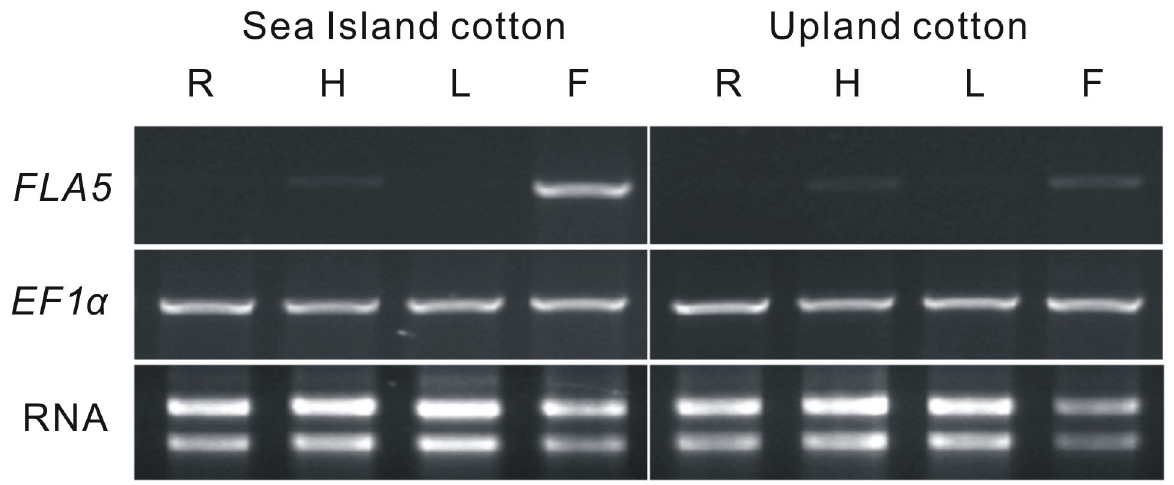
Figure 6. Expression analysis of FLA5 in various cotton tissues by semi-quantitative RT-PCR. EF1α was used as the internal control. Sea Island cotton ( G. barbadense cv. Pima90-53), Upland cotton (cid:0) G . hirsutum cv. CRI 8) and tissues of Root (R), hypocotyl (H), leaf (L) and 25 DPA fibers (F) were marked on the top.